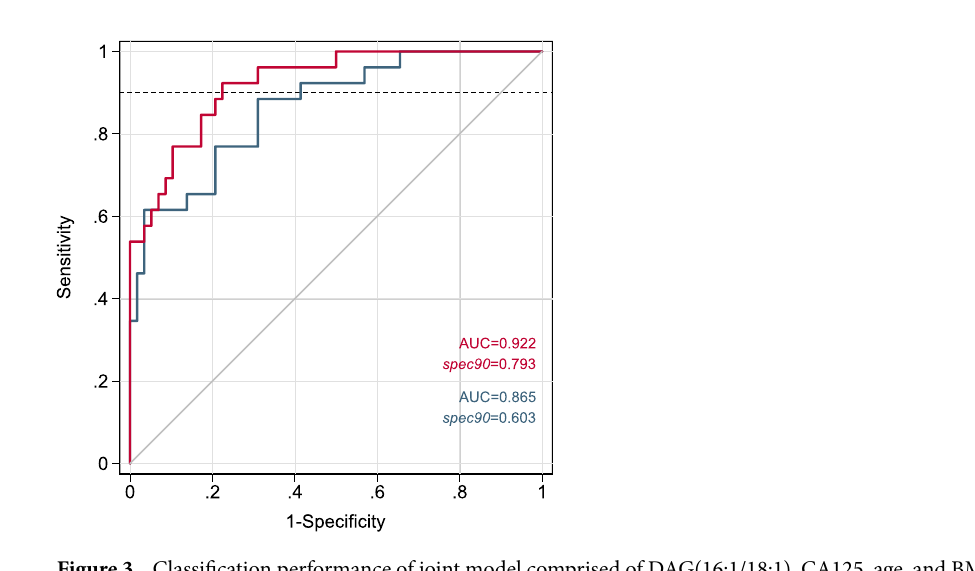
Figure 3. Classification performance of joint model comprised of DAG(16:1/18:1), CA125, age, and BMI, versus base model comprised of CA125, age, and BMI only. ROC curve analysis conducted using RP cohort data from early-stage (I–II) cases and controls. Joint model (red), base model